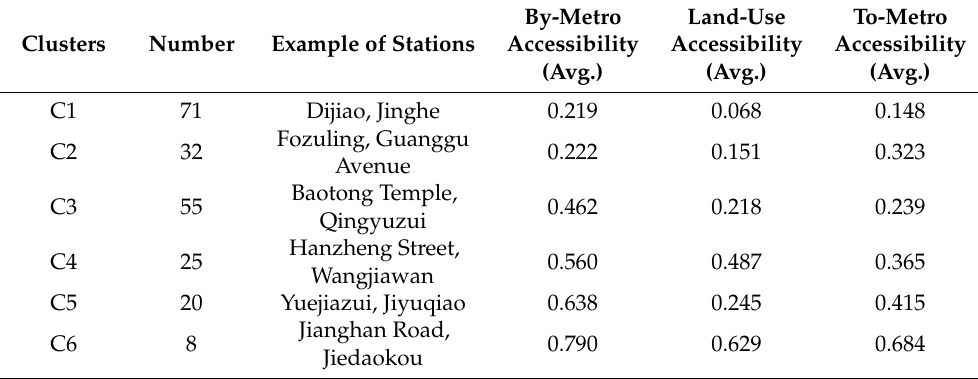
Figure 6. Scatter plots of by-metro accessibility, land-use accessibility, to-metro accessibility of Wuhan metro stations. Table 3. Summary of cluster